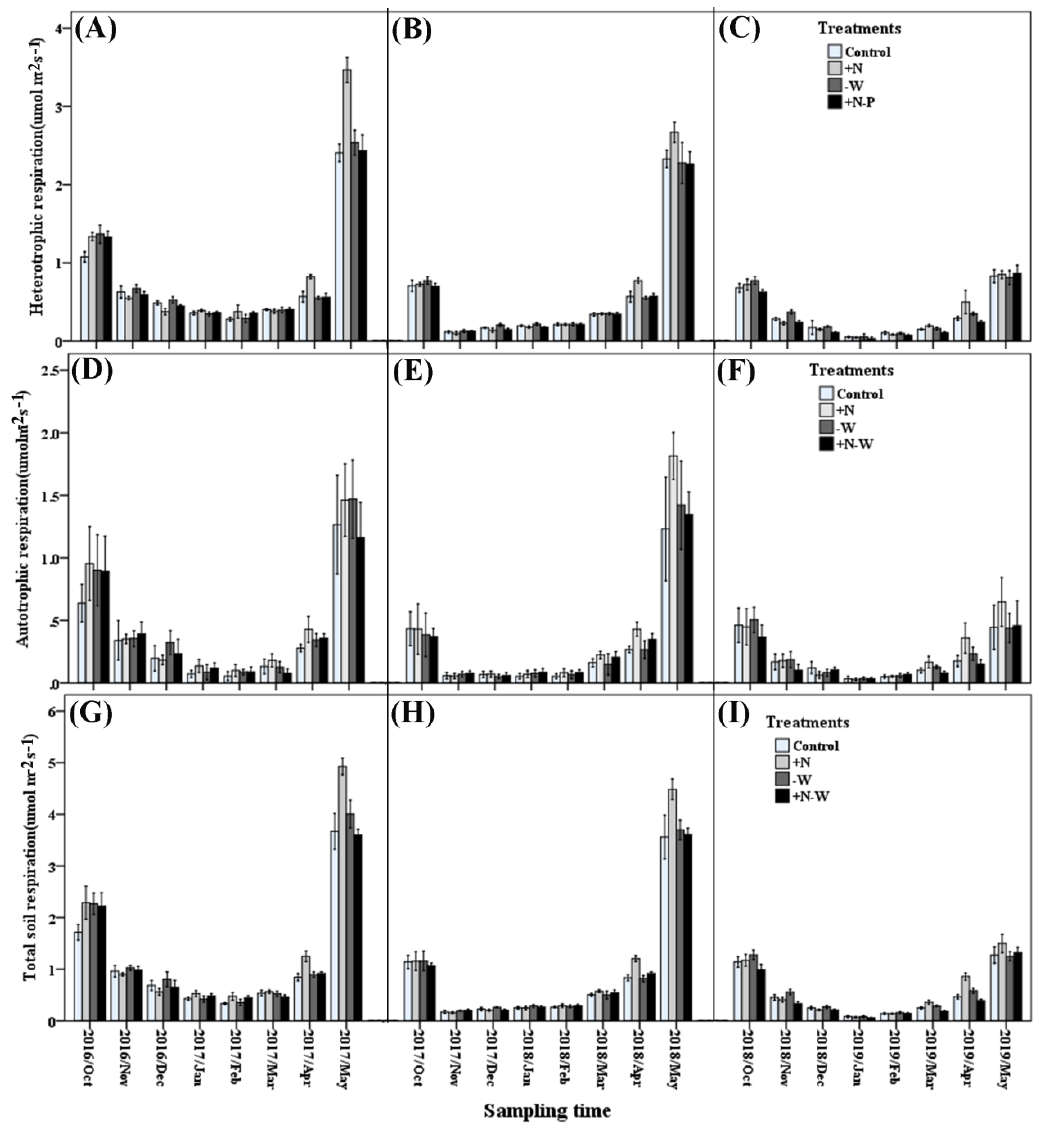
Figure 2. Temporal changes in heterotrophic respiration ( A – C ), autotrophic respiration ( D – F ), and total soil respiration ( G – I ), among the different treatments during the measurement periods in the 2016/2017, 2017/2018, and 2018/2019. The error bars are standard errors. +N represents the N addition treatments; -W represents the precipitation reduction treatments; and +N-W represents the combined effect of N addition and precipitation reduction.